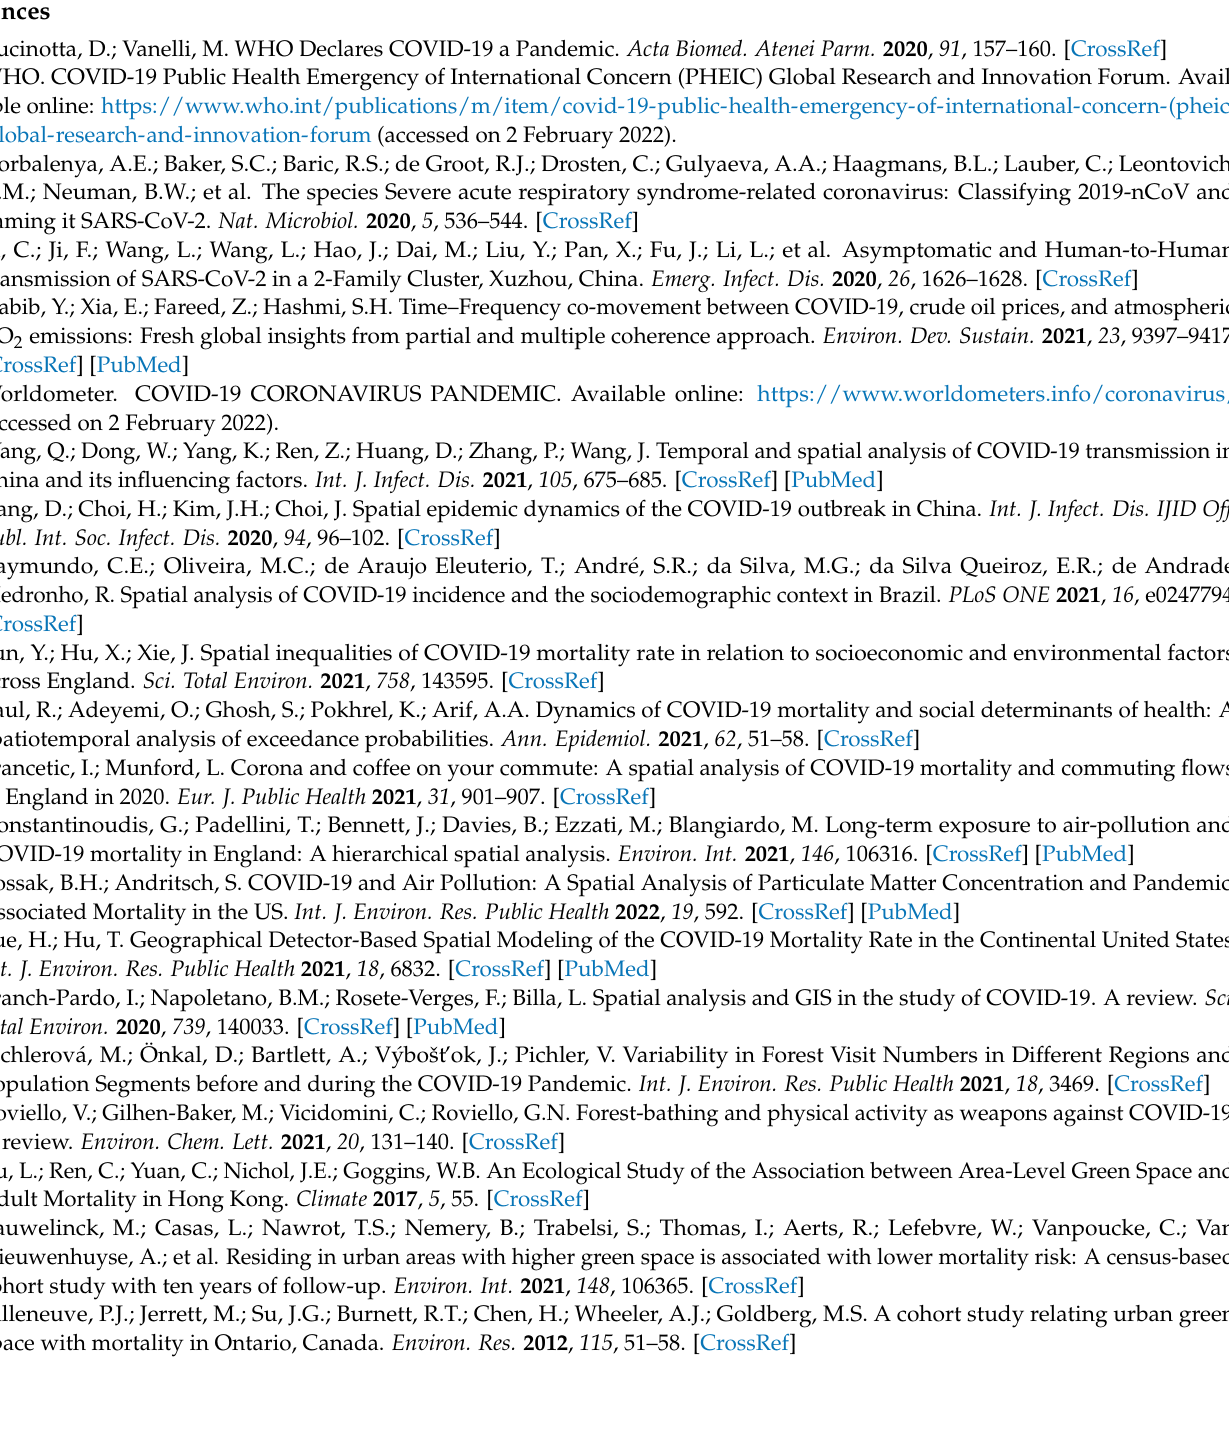
Table S2: Changes in COVID-19 CFR (‰) per 10% increase in the ecological and socioeconomic variables (including GDP per capita instead of CO 2 emission per capita); Table S3: Changes in COVID-19 CFR (‰) per 10% increase in the ecological and socioeconomic variables (including GDP per capita instead of CO 2 emission per capita; and forest area per capita instead of forest